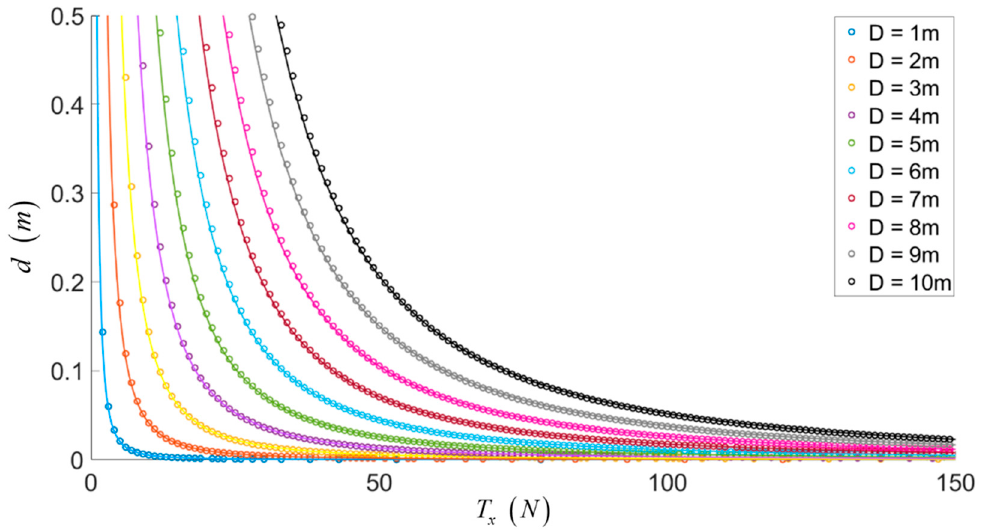
Figure 10. The relationship between T x and d with di ff erent D and fixed β = 0.754 rad